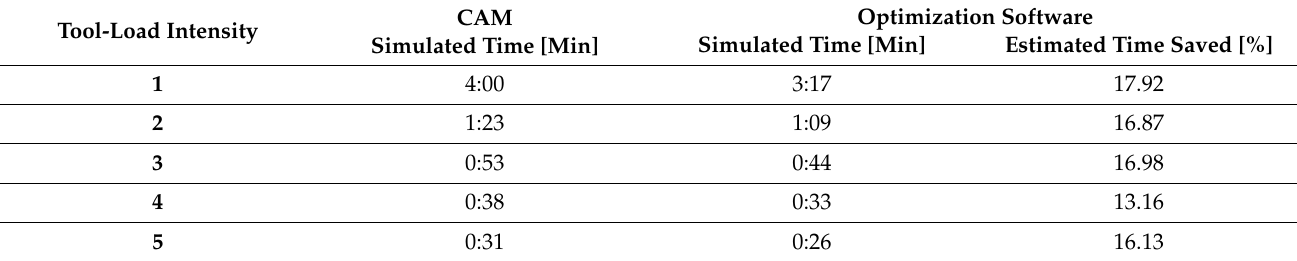
Table 8. Machining times from simulations and expected time savings.